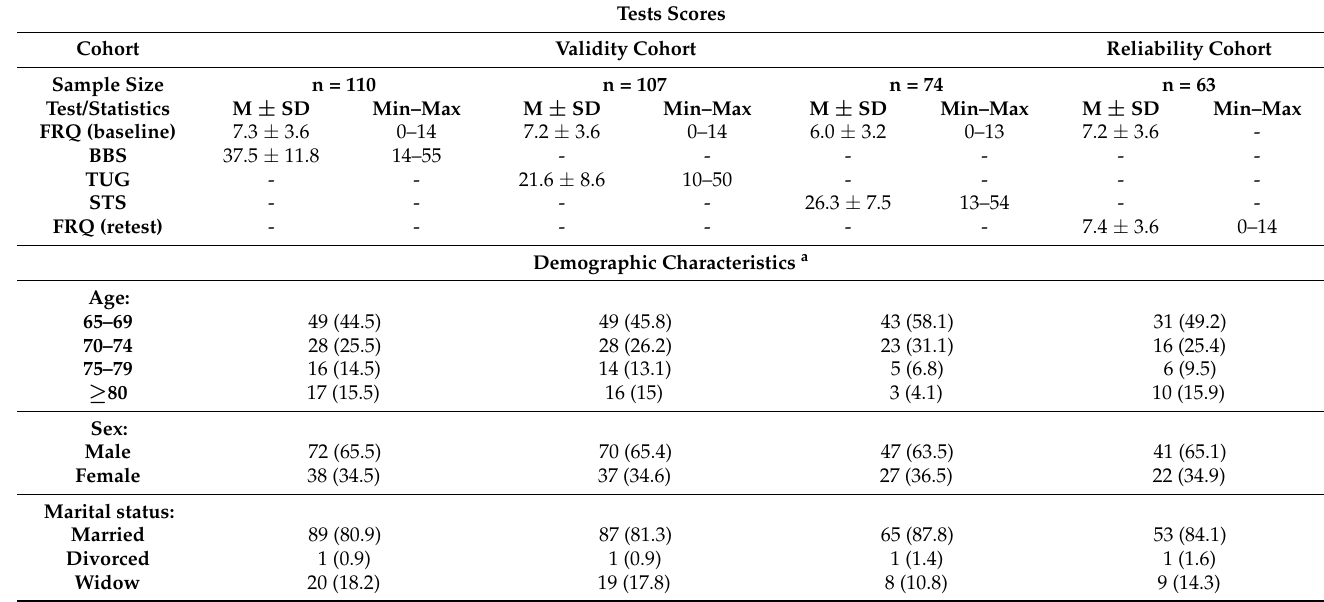
Table 2. Participant scores at baseline and follow-up assessment with demographic